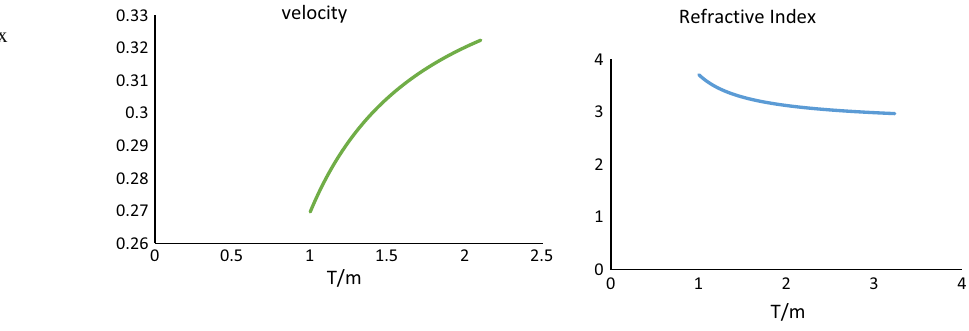
Fig. 6 Plot of propagation velocity and the refractive index in an extremely hot